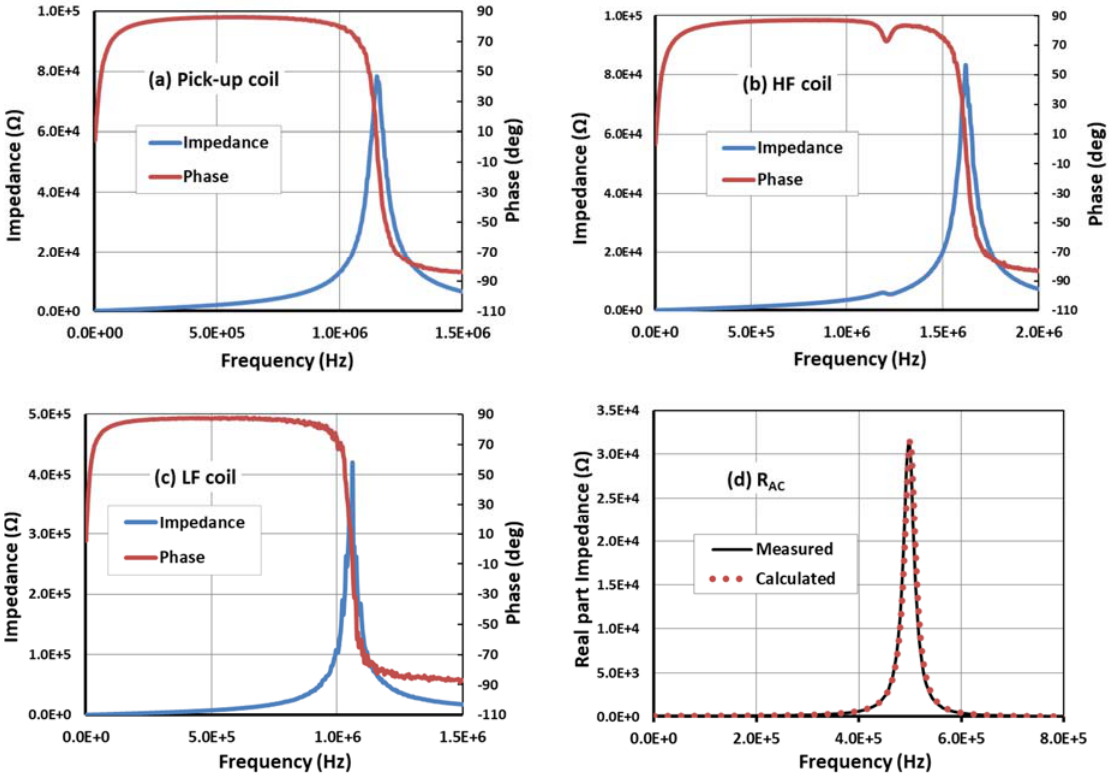
Figure 6. Effect of the frequency on the impedance of the ( a ) pick-up; ( b ) HF; and ( c ) LF coils; and ( d ) effect of the operating frequency on the AC resistance.